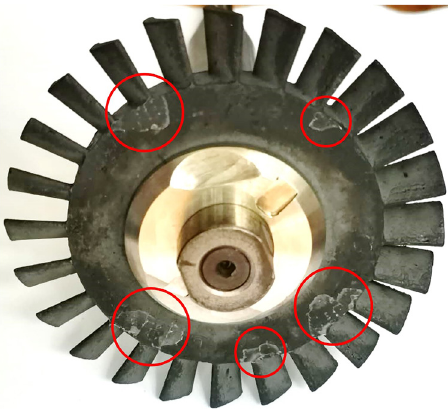
Figure 8: Coating spalling of SWS - SiC/SiC turbine blisk after the fi rst